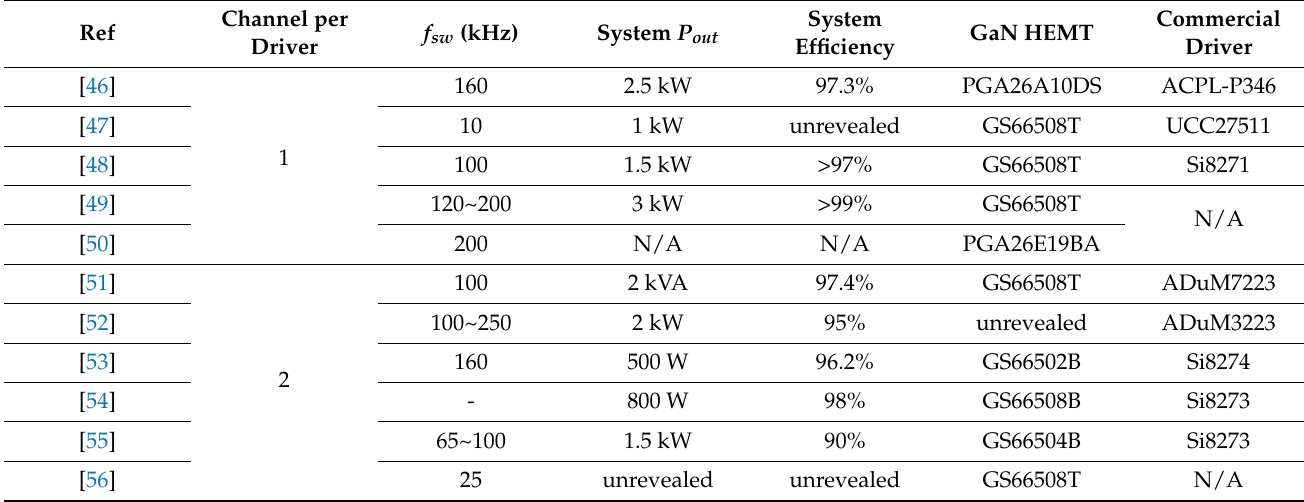
Table 38. Reviewed GaN HEMT driving